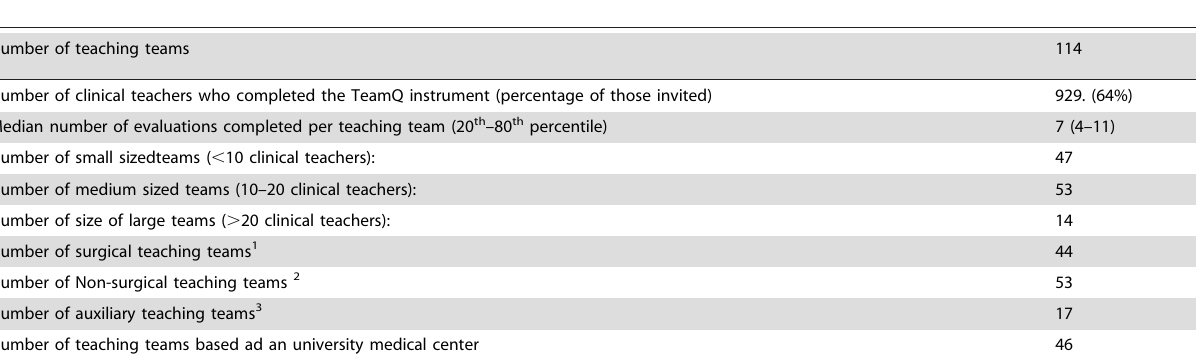
Table 2. Characteristics of the participants in the testing phase of the TeamQ